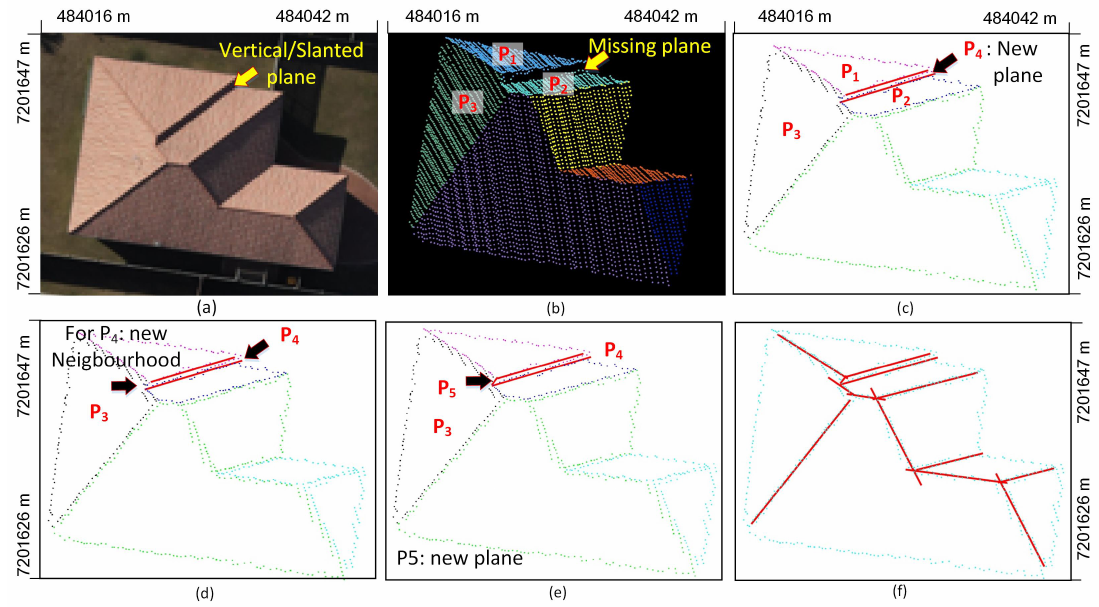
Figure 3. Insertion of a real vertical plane: ( a ) test building image for demonstration; ( b ) input roof planes for corresponding building and location of missing plane; ( c ) insertion of a new vertical plane P 4 ; ( d ) assessing adjacency between existing plane P 3 and new plane P 4 ; ( e ) insertion of a new vertical plane P 5 between P 3 and P 4 ; and ( f ) 3-D view of building roof planes and intersection lines for